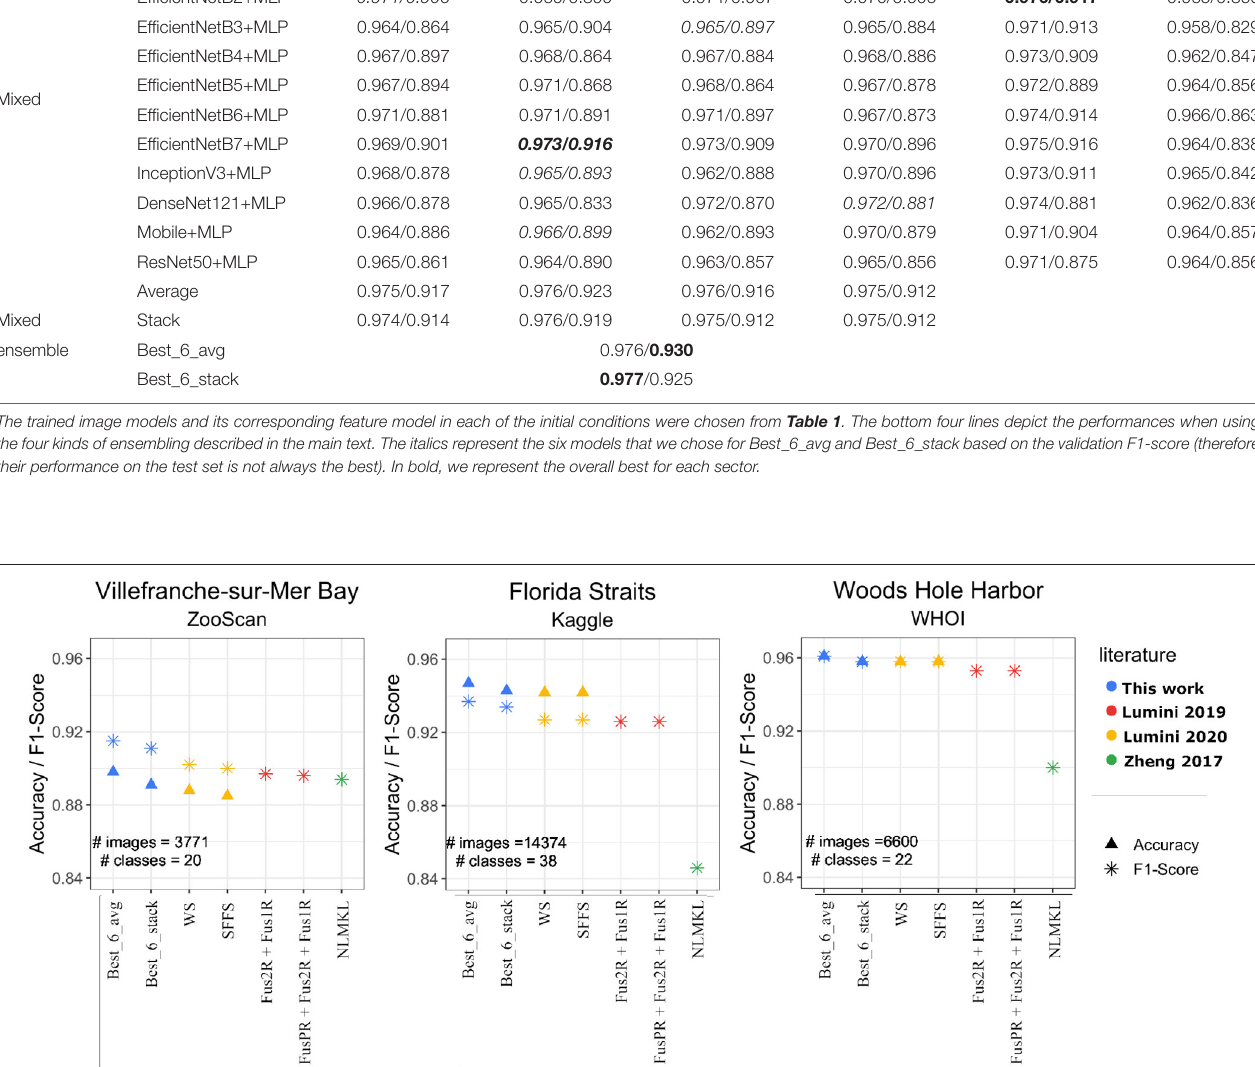
FIGURE 4 | Performances Accuracy/F1-score of our Best_6_avg and Best_6_stack models (blue points) on the publicly available datasets (ZooScan, Kaggle, WHOI), and comparison with previous results from literature. The yellow points indicate ensemble models from (Lumini et al., 2020): SFFS (Sequential Forward Floating Selection—a feature selection method used to select models), WS (Weighed Selection—a stacking method that maximizes the performance while minimizing the number of classifiers). The red points are the Fus models from (Lumini and Nanni, 2019), which fuse diverse architectures and preprocessing. The green points stand for non-linear multi kernel learning (NLMKL), where an optimal non-linear combination of multiple kernels (Gaussian, Polynomial, and Linear) is learnt to combine multiple extracted plankton features.